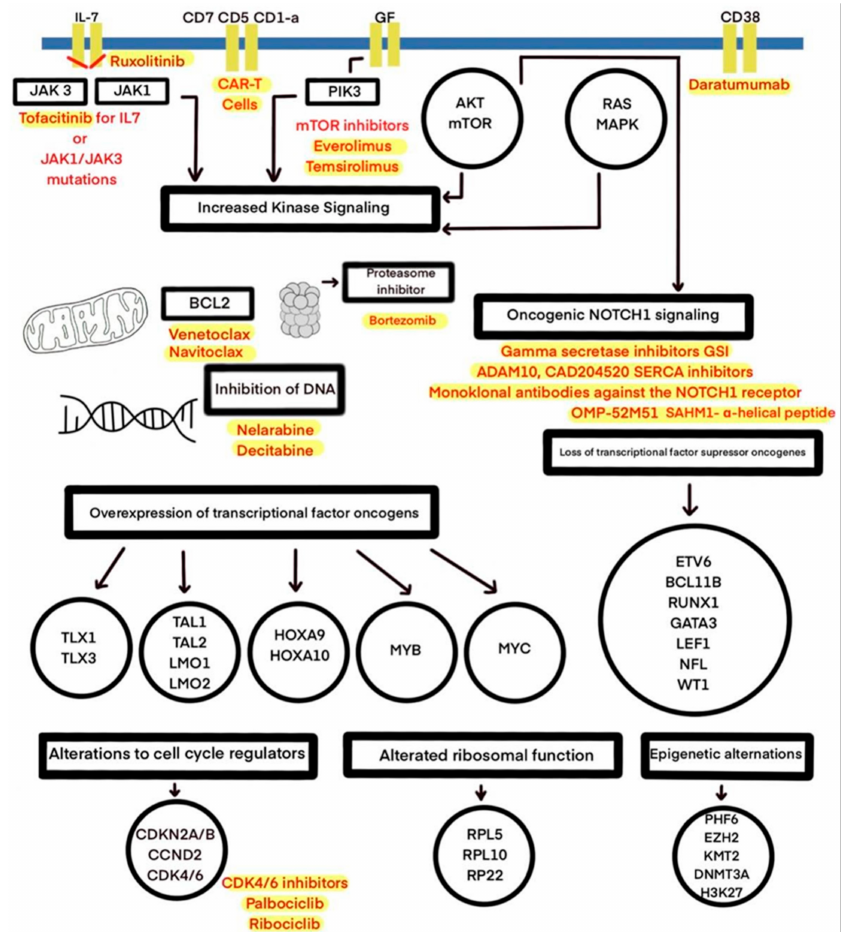
Figure 1. The molecular therapeutic targets used in preclinical and clinical studies of T-ALL treatment. Apart from the limitations and constant improvements in GSI therapy, distinct